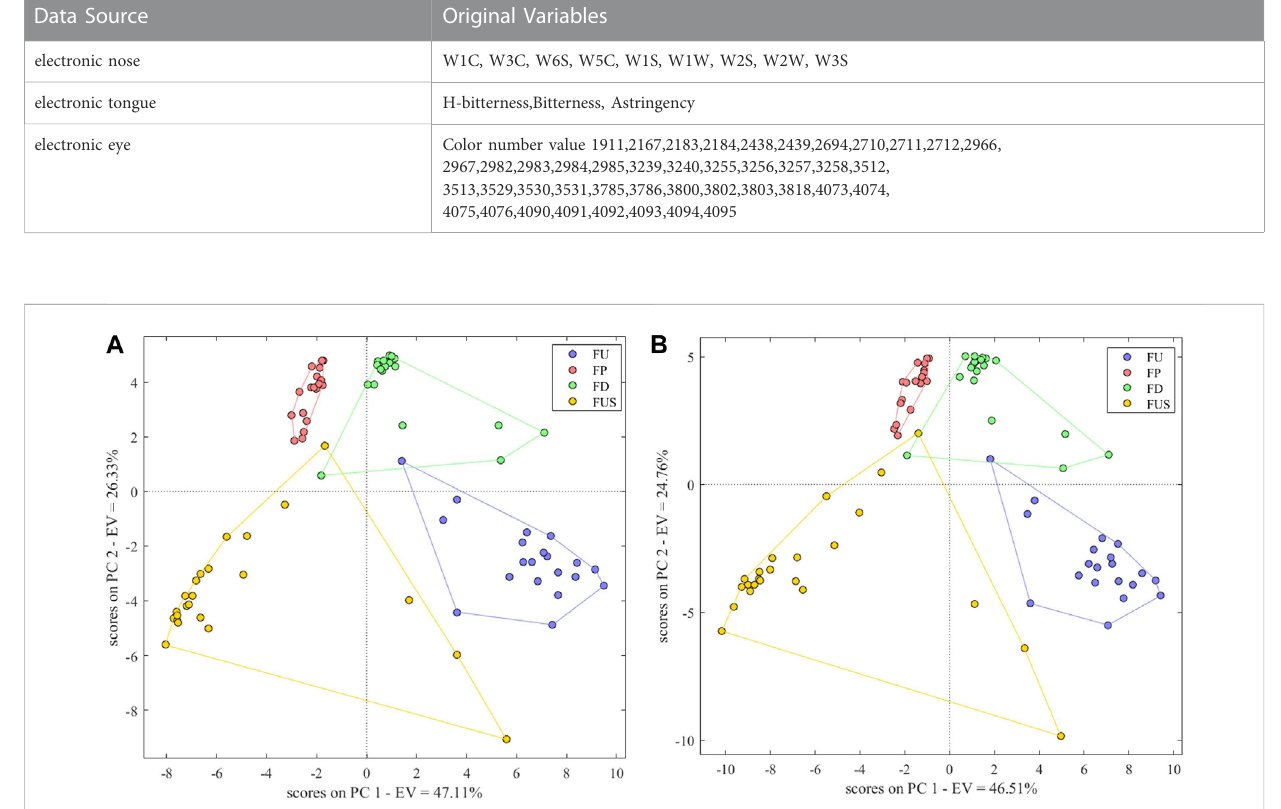
FIGURE 8 ScoresPlotofPCA-DAspeciesidenti fi cationmodelbasedonthree-sourcefusion (A) (EN+ET+EE)andfour-sourcefusion (B) (EN+ET+EE+NIR).